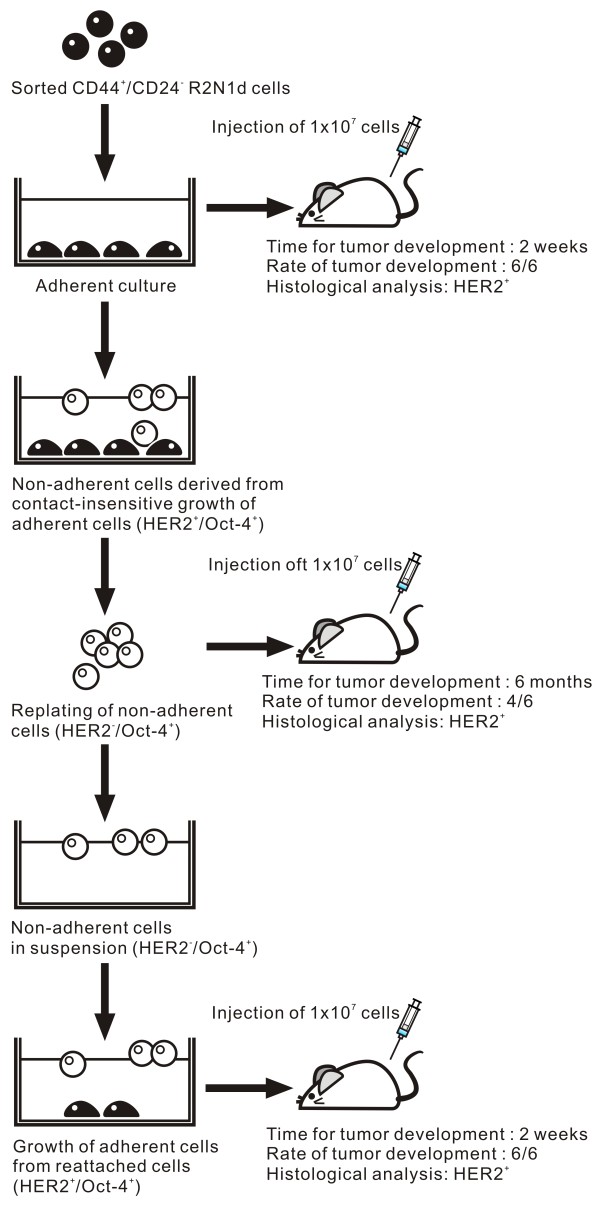
A diagram depicting the change in HER2 expression and tumorigenicity of R2N1d (CD44+/CD24- sorted) cells due to cell culture condition. Adherent R2N1d cells were OCT4+/HER2+ and highly tumorigenic (tumor developed in 1 month after inoculation), the non-adherent R2N1d cells detached from confluent R2N1d cells in suspension were OCT4+/HER2- and took longer time (6 months) to develop tumor at lower frequency. The reattached R2N1d cells from non-adherent cells were similar to parental adherent cells in OCT4+/HER2+ expression and tumor development.